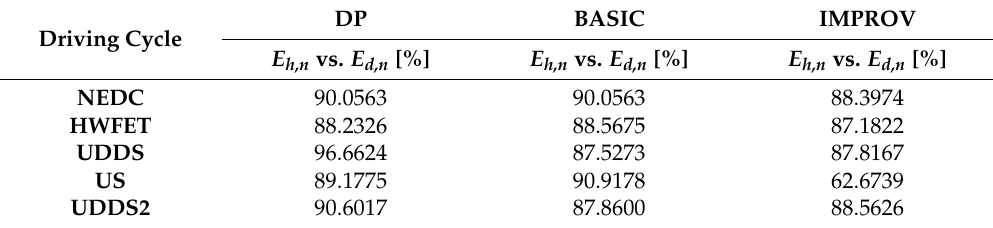
Table 2. The share of regenerative braking energy in total braking